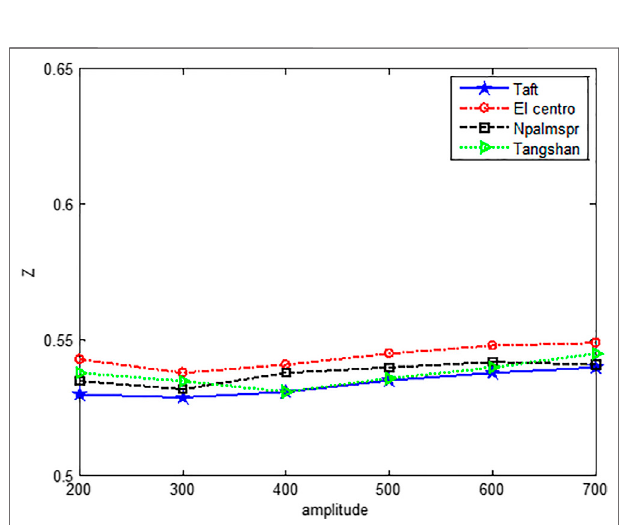
FIGURE 8 | Sensitivity of the objective function to earthquake